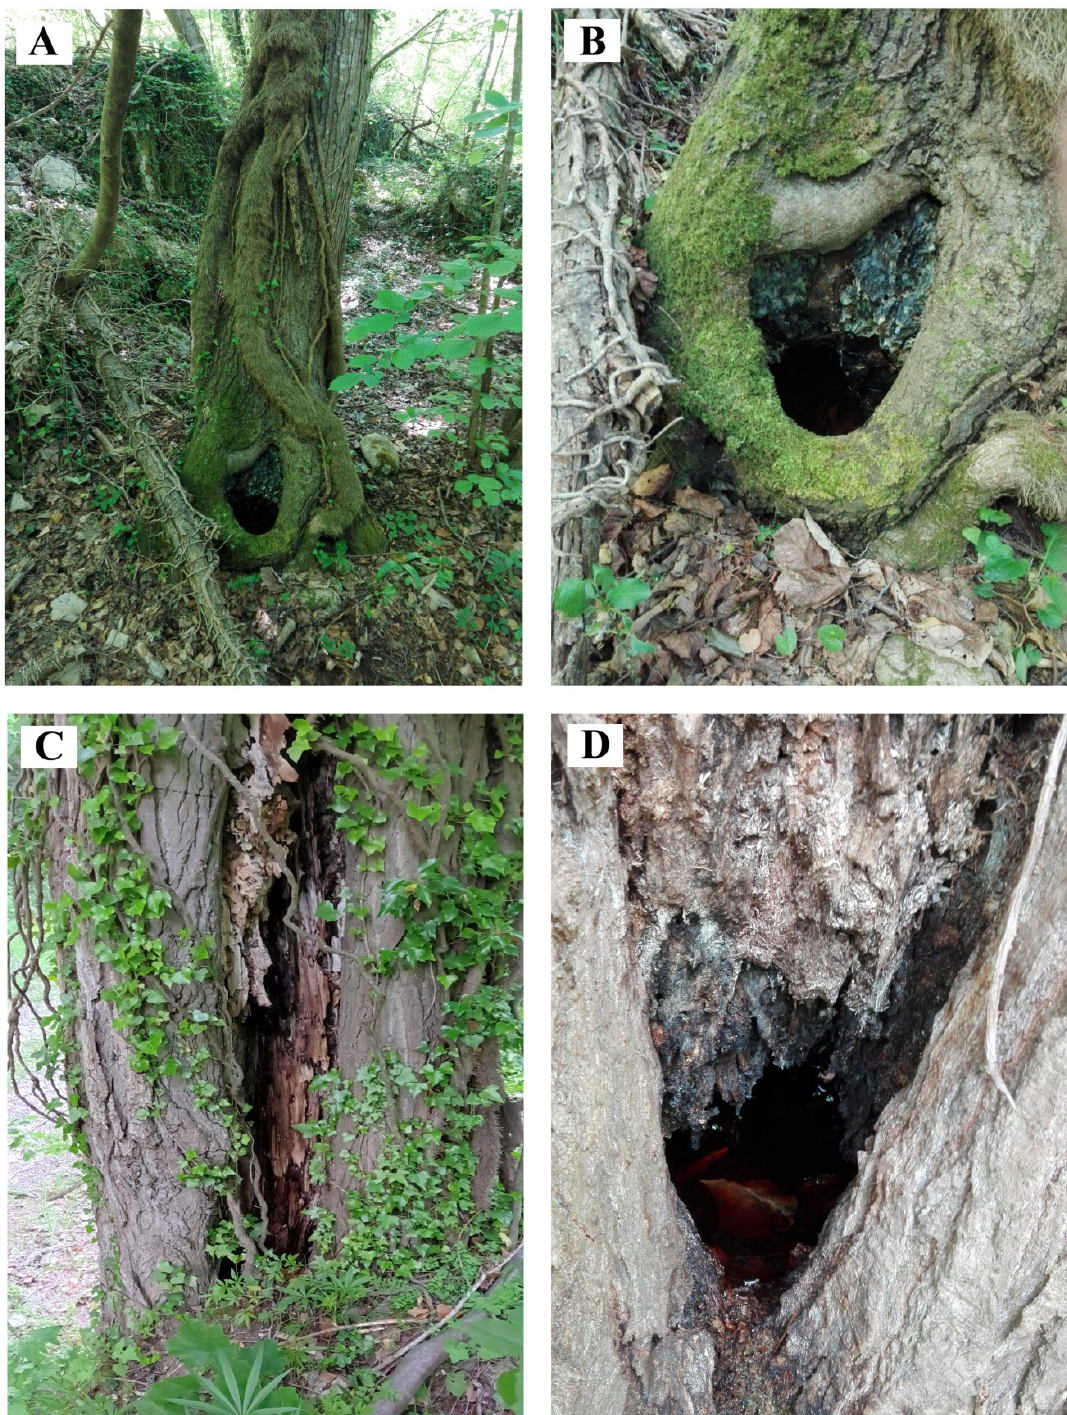
Figure 14. ( A , B ) Habitat of Psychoda cinerea Banks, 1894, dendrotelma of hornbeam ( Carpinus or Ostrya sp.). ( C , D ) Habitat of Lepiseodina tristis (Meigen, 1830), rotting tree hole with basal dendrotelma of Populus nigra . All in a mixed submontan forest (Foro Valley, central Italy). Examined material: ZFMK-DIP-00081311, ZFMK-DIP-00081322, ZFMK-DIP-00081323, Lepiseodina rothschildi (Eaton, 1912) ZFMK-DIP-00081324, ZFMK-DIP-00081327, ZFMK-DIP-00081328, ZFMK-DIP-00081329, Figures 3, 8G,H and 9B ZFMK-DIP-00081330, ZFMK-DIP-00081510, ZFMK-DIP-00081537, ZFMK-DIP-00081551, Telmatoscopus rothschildii Eaton, 1912: 7. Type locality: England, London, Hyde Park. ZFMK-DIP-00081558, ZFMK-DIP-00081559, ZFMK-DIP-00081567,